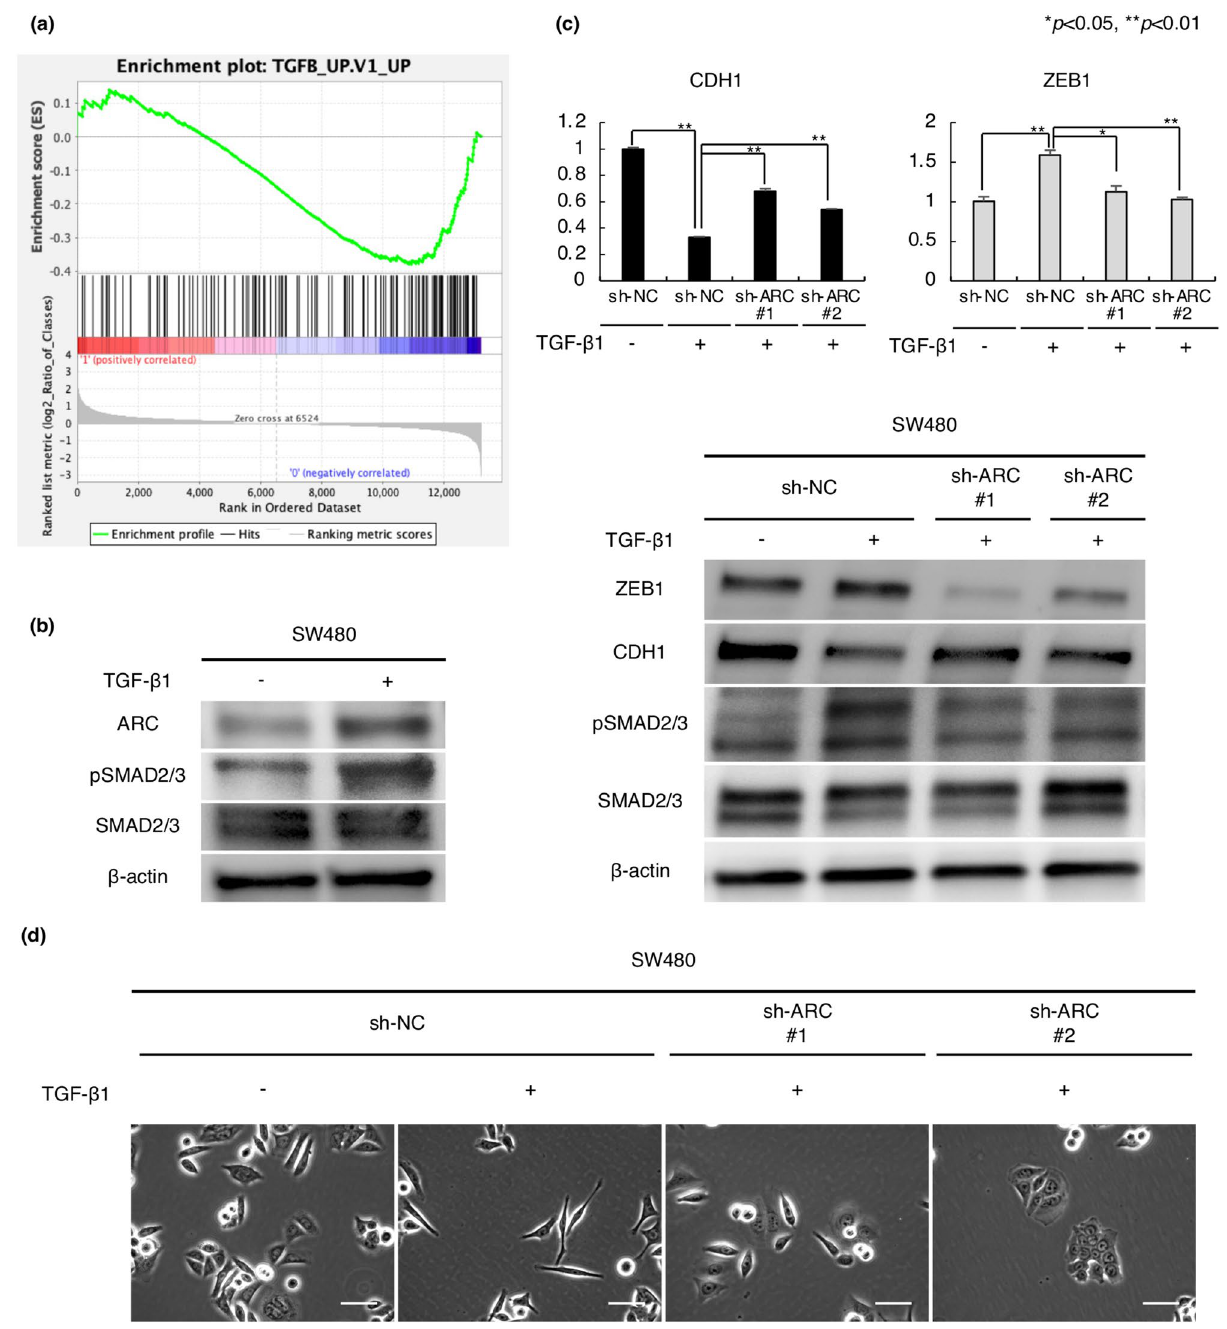
Figure 5. Involvement of ARC in TGF-β-mediated EMT pathway. ( a ) Association between ARC expression and upregulated genes in a panel of epithelial cell lines by TGF-β1 in GSEA (NES = − 1.499, q = 0.130). ( b ) Alteration of ARC expression in response to TGF-β1 in western blot analysis. Full-length blots are presented in Supplementary Fig. 11d. ( c ) Alteration of CDH1 expression in sh-NC and sh-ARC SW480 cell lines in response to TGF-β1 in qPCR and alteration of CDH1 and ZEB1 expression in sh-NC and sh-ARC SW480 cells in response to TGF-β1 in western blot analysis. Error bars show standard errors of the mean. Asterisks denote significant difference using unpaired 2-tail t-test (* p < 0.05, ** p < 0.01). Full-length blots are presented in Supplementary Fig. 111. (d) TGF-β1-induced change in cell shape in sh-NC and sh-ARC SW480 cell lines. Scale bars indicate 50 µm. Experiments were conducted in triplicate. TGF transforming growth factor, EMT epithelial–mesenchymal transition, GSEA gene set enrichment analysis, NES normalized enrichment score, sh short hairpin, NC negative control, qPCR quantitative polymerase chain